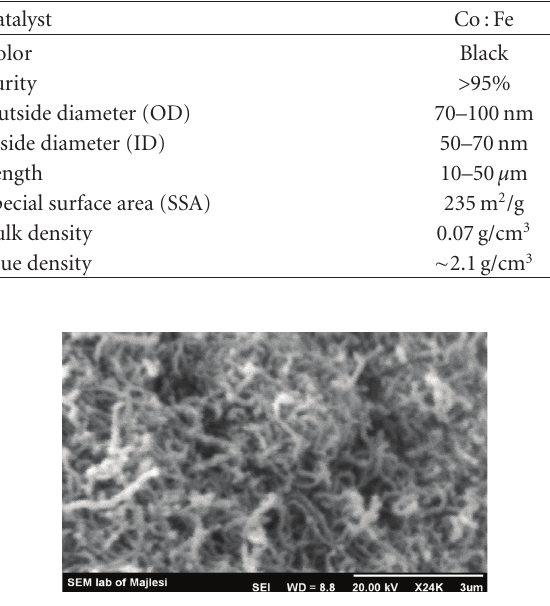
Figure 1: SEM image of